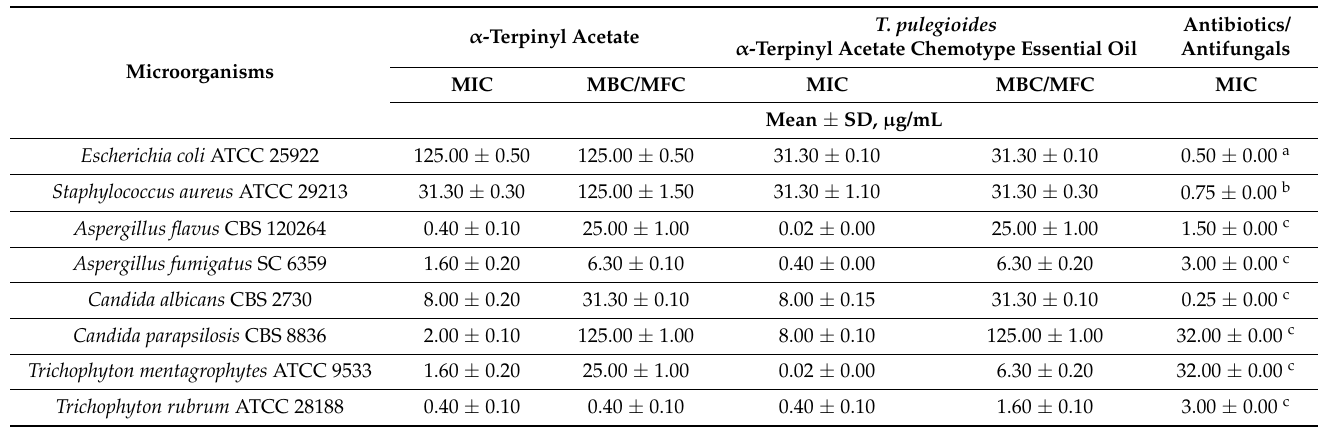
Table 6. Minimum inhibitory concentrations (MICs) and minimum bactericidal/fungicidal concentrations (MBCs/MFCs) values of essential oil of Thymus pulegioides α -terpinyl acetate chemotype and analytical standard of α -terpinyl acetate against different groups of microorganisms (SD—standard